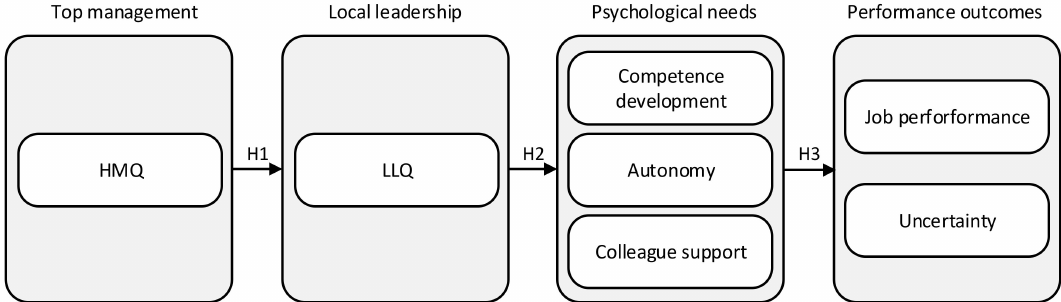
Figure 1. Research model. HMQ: Hospital management quality; LLQ: Local leadership